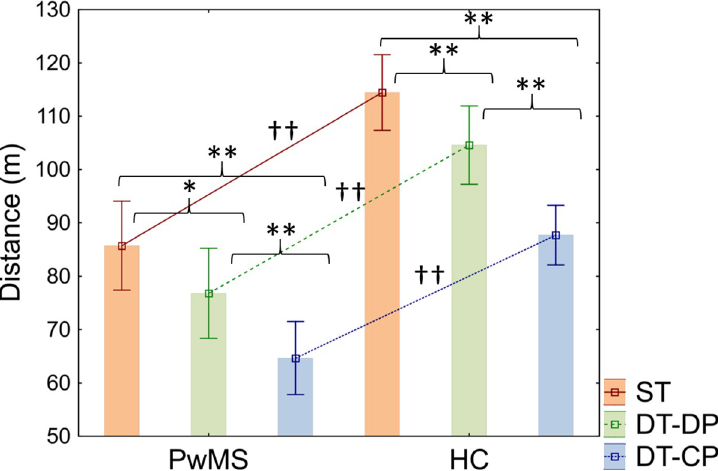
Fig 1. Cognitive-motor interference over motor performance. Distance (m) walked (mean ± standard deviation) during single task (ST), dual task with double priority (DT-DP) and dual task with cognitive priority (DT-CP) by people with multiple sclerosis (pwMS) and healthy controls (HC). Significant contrasts are indicated by the black lines over the graph. � p < 0.05, �� p < 0.01, denoting significant intragroup contrasts -ST vs DT-DP, ST vs DT-CP and DT-DP vs DT-CP- in pwMS and HC, respectively.† p < 0.05, †† p < 0.01, denoting significant between-group contrasts -pwMS vs